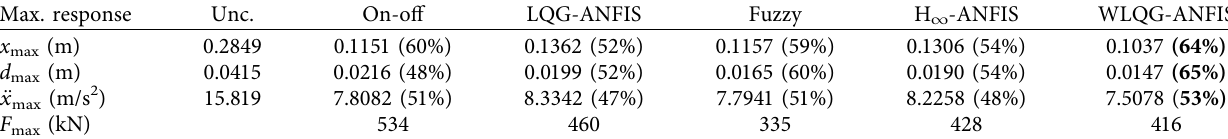
Table 6: Maximum responses (reduction ratios) and damping force with different control strategies. Max. response